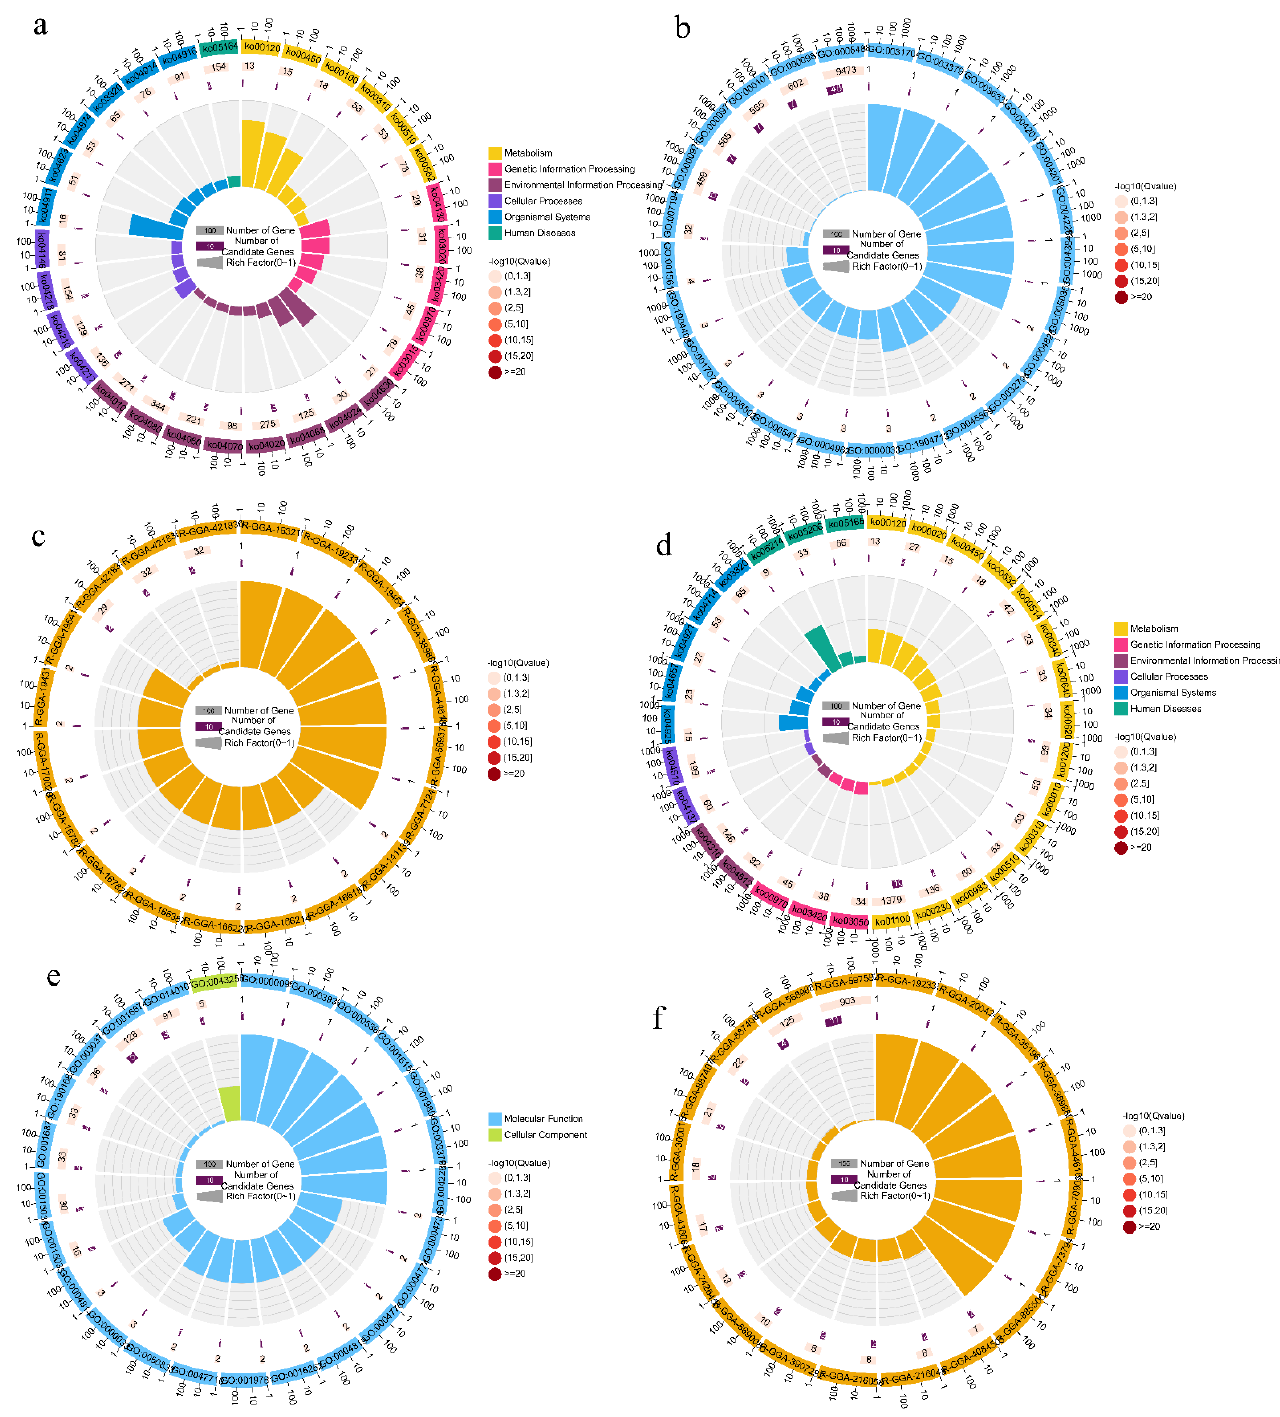
Figure 6. Functional enrichment analysis of the shin color candidate genes. ( a – c ) KEGG, GO, and Reactome pathway enrichment of black shin candidate genes; ( d – f ) KEGG, GO, and Reactome path- way enrichment of yellow shin candidate